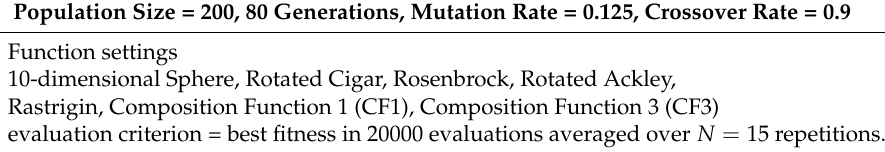
Table 7. Optimization of seven different functions. Experimental settings. EMOPaT